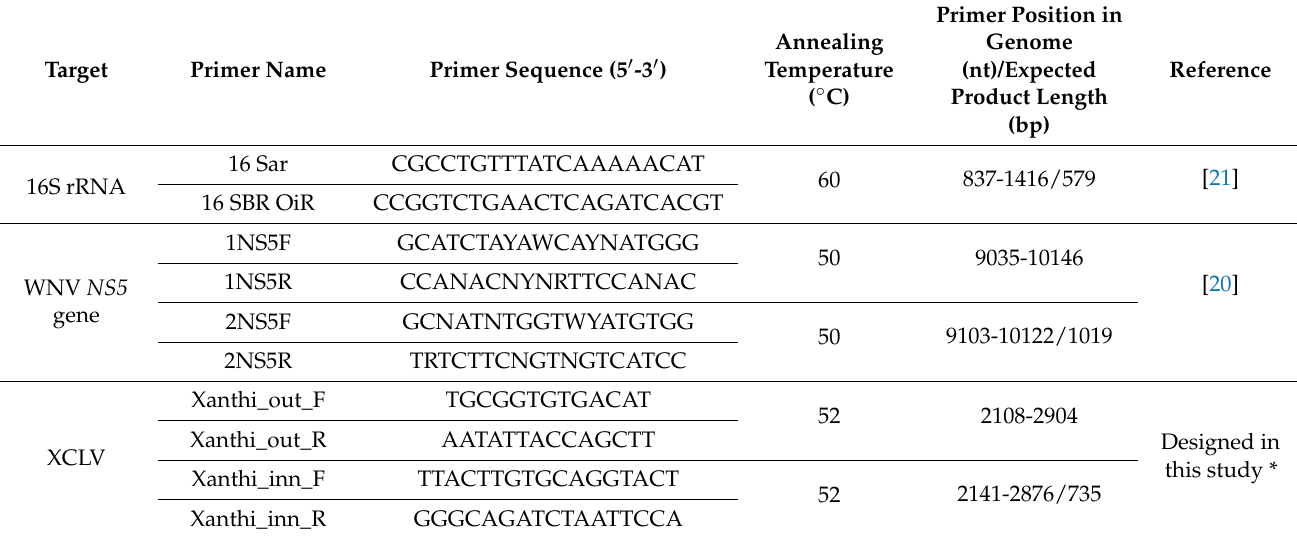
Table 1. List of primers used in the